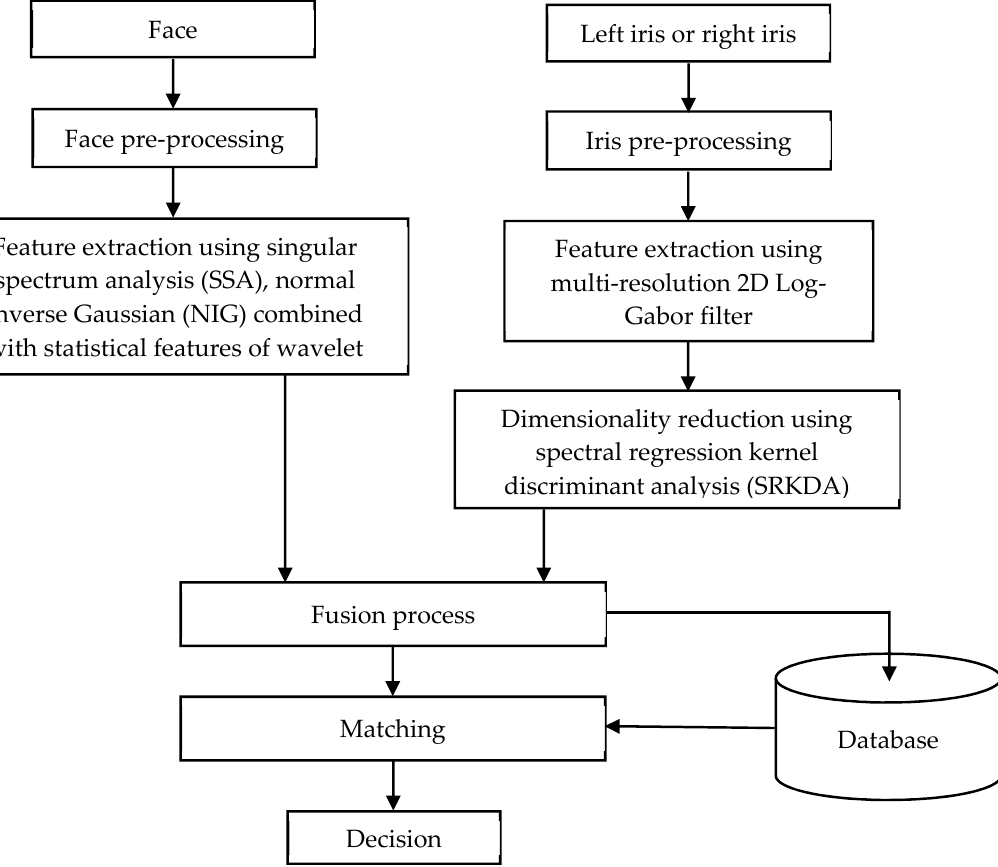
Figure 1. Block diagram of the proposed multimodal biometric system. Electronics 2019 , 8 , x FOR PEER REVIEW